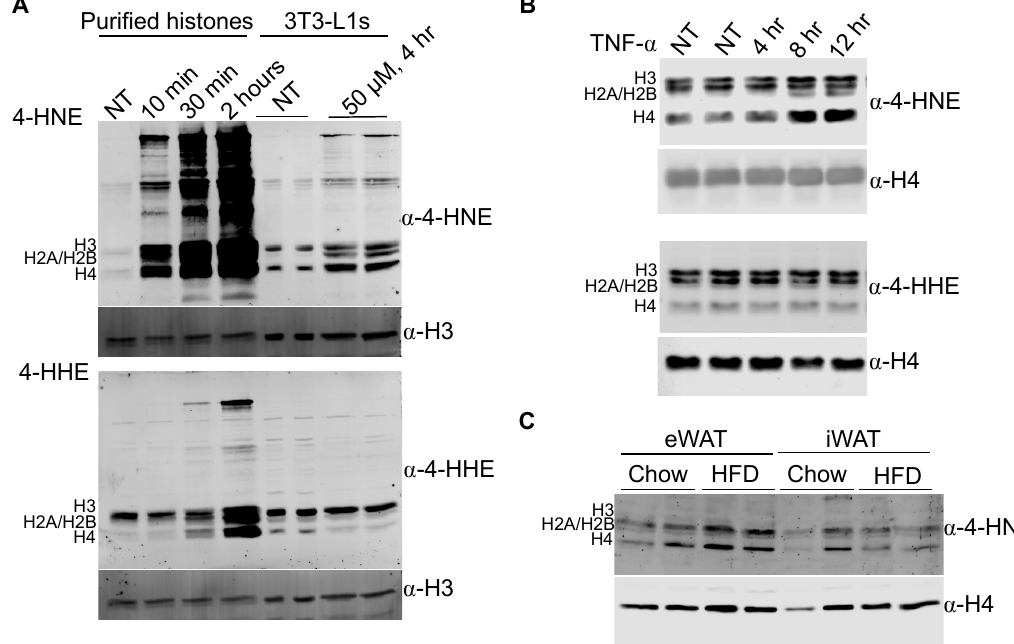
Figure 1. 4-HNE modification of histones occurs in vivo and is increased in obese animals. ( A ) Western blot of in vitro modification of histones with 4-HNE (upper panel) and 4-HHE (lower panel). Acid-extracted histones from 3T3-L1 adipocytes were modified by 4-HNE or 4-HHE for the indicated time in vitro (lanes 1–4). 3T3-L1 adipocytes were treated on day 8 of di ff erentiation with vehicle, 4-HNE (upper), or 4-HHE (lower), followed by histone extraction and analysis by Western blot (lanes 5–8). ( B ) 3T3-L1 adipocytes treated with 0.5 nM TNF α on day 8 of di ff erentiation for 4, 8, and 12 h. 4-HNE (upper) and 4-HHE (lower) modifications on purified histones. ( C ) 4-HNE modification of histones purified from eWAT and iWAT of chow- and high-fat-diet-fed (HFD) mice. NT indicates no treatment (vehicle) control.